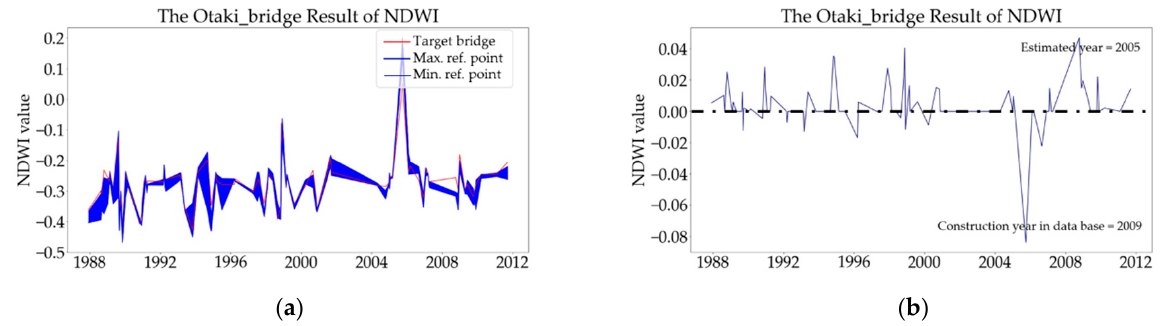
Figure 28. ( a ) NDWI results for the O Ta Ki bridges, from which the year of construction is estimated to be 2005; ( b ) re-visualization of ( a ) showing a sudden NDWI deviation in 2005.